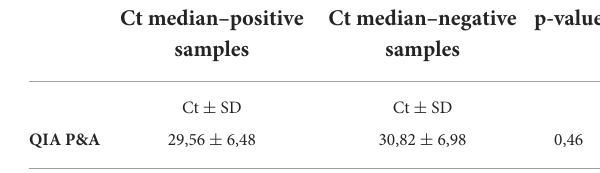
TABLE 5 Median CTs of the N gene of samples with positive and negative results obtained with the QIA P&A